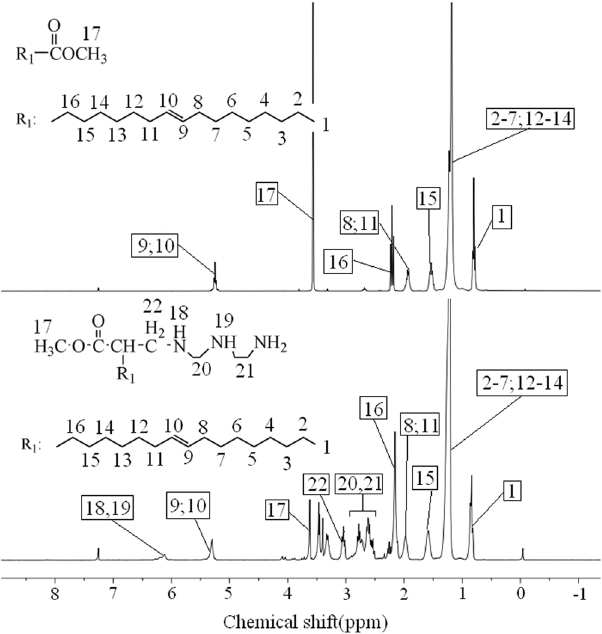
Figure 3. 1 H NMR spectra of WCOME and mannich base of